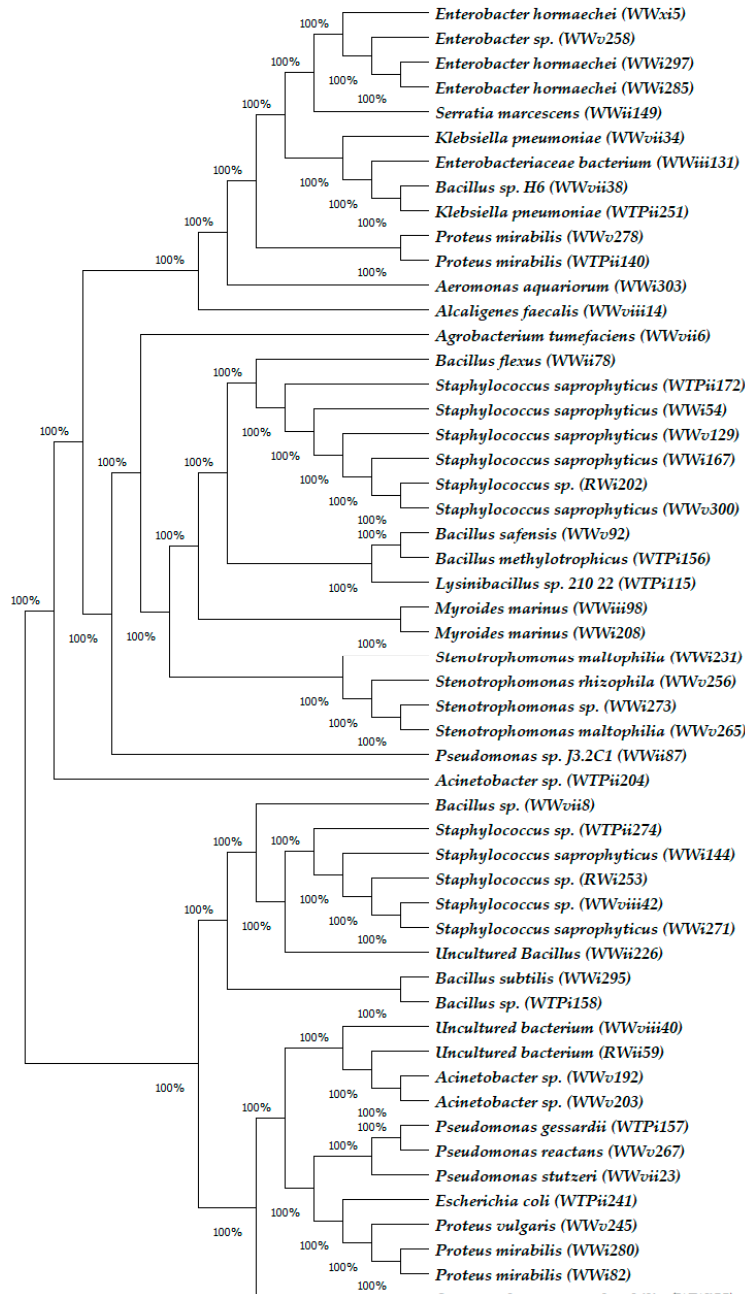
Figure 1. Neighbor-joining Phylogenetic tree of Bacterial isolates obtained from WW, WTP and RW. Parenthesis indicates species code of bacterial isolate, indicating isolate